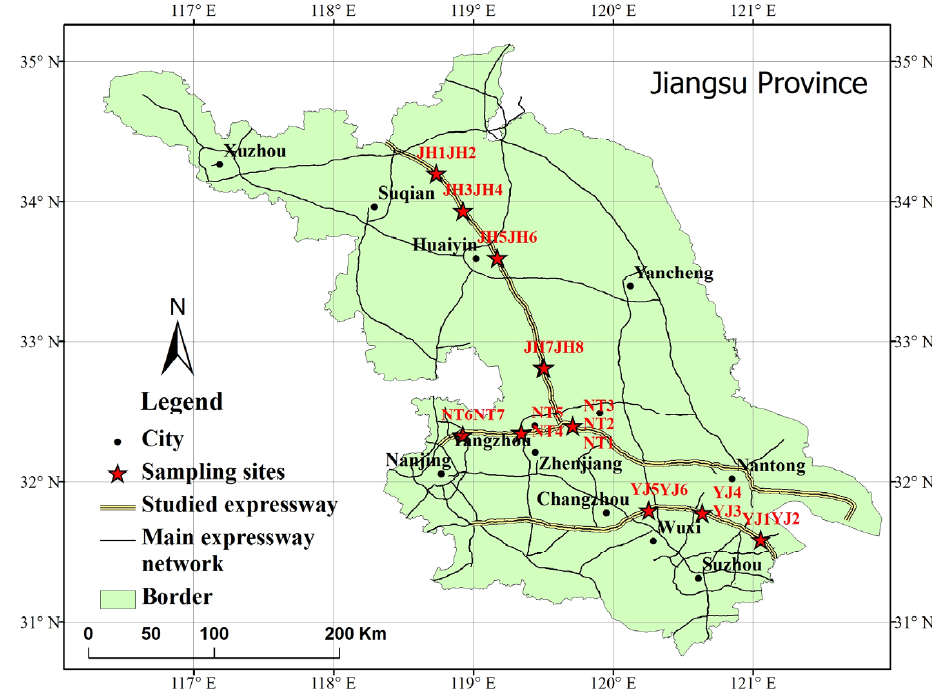
Figure 1. The study areas and sampling sites. Table 1. Characteristics of studied highways.